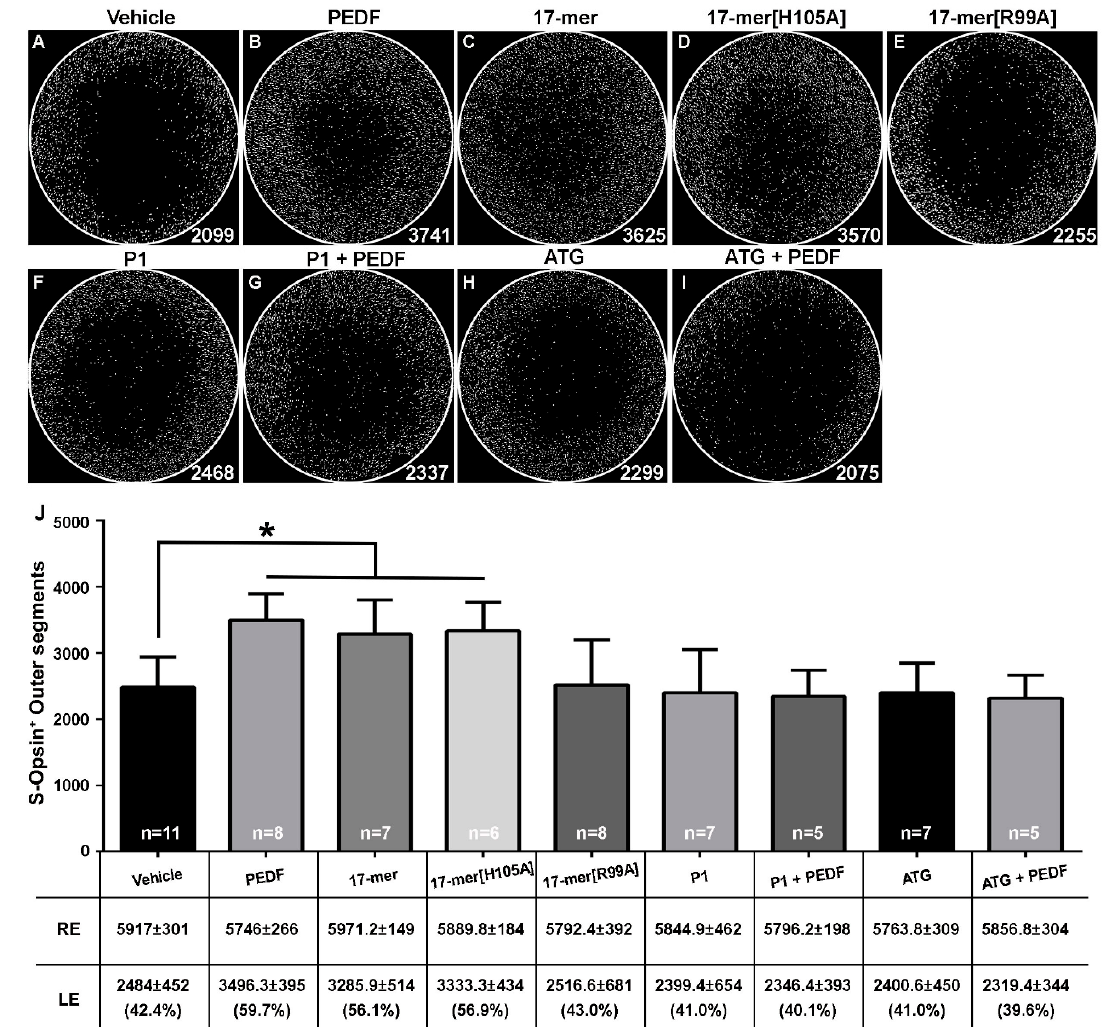
Figure 2. Effects of full-length PEDF and 17-mer, 17-mer[H105A] and 17-mer[R99A] peptides on LIP injured S-cones. Panels A-I show the S-opsin + OS automatically counted and represented as white dots in representative experimental PFAs tested with vehicle ( A ), full length PEDF ( B ), 17-mer ( C ), 17-mer[H105A] ( D ) and 17-mer[R99A] ( E ) peptides, P1 a blocking peptide, alone ( F ) or in combination with PEDF ( G ) or ATG, a PEDF-R inhibitor, alone ( H ) or in combination with PEDF ( I ). Panel ( J ) shows a bar graph and a table showing S-opsin + OS automatically counted and represented as white dots, that survive at 7 days after LIP in PFA treated with the different treatments indicated in the x -axis. The numbers of cones counted with PFA are expressed as mean ± SD and in parentheses as the percentage of survival compared to the mean number of cones counted all right contralateral PFAs of group B (5853 ± 310 S-opsin + OS; n = 64) (* p < 0.05).